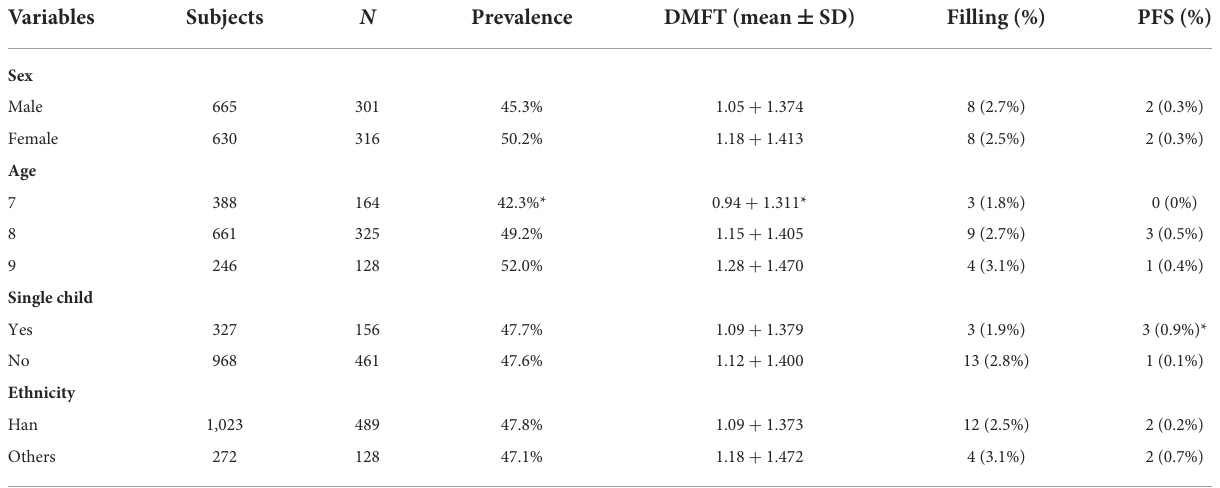
TABLE 1 Prevalence of caries, DMFT, filling rate and pit and fissure sealant rate of first permanent molar according to different children’s characteristics ( N = 1,295). Variables